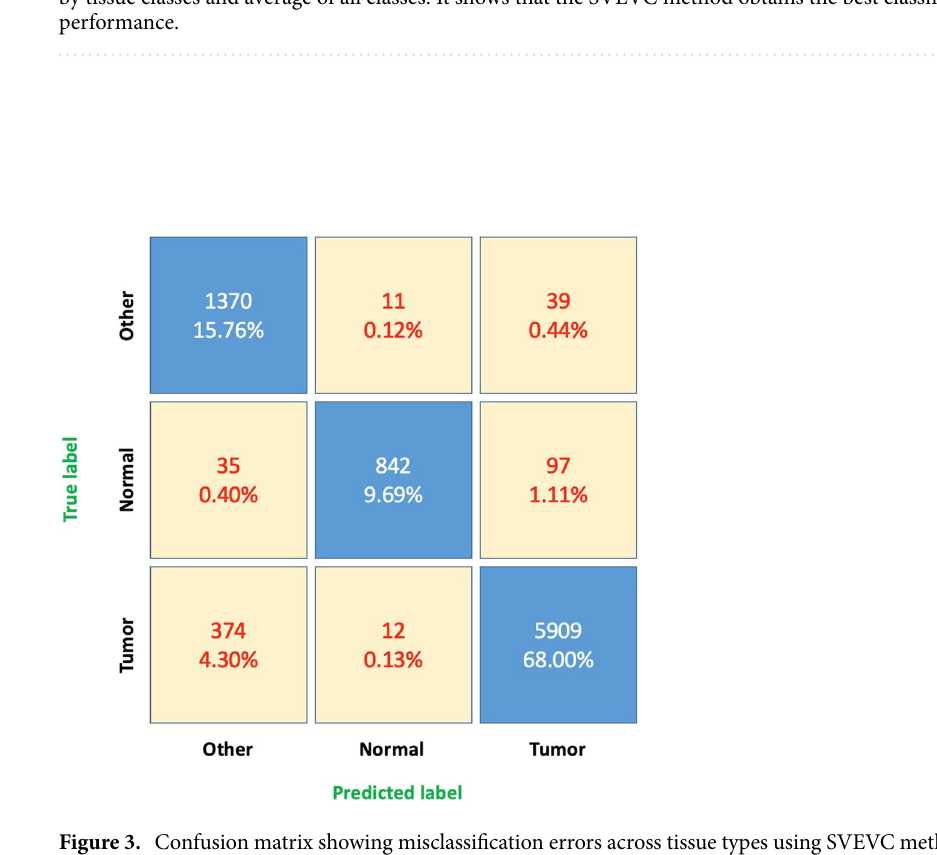
Figure 3. Confusion matrix showing misclassification errors across tissue types using SVEVC method in evaluation